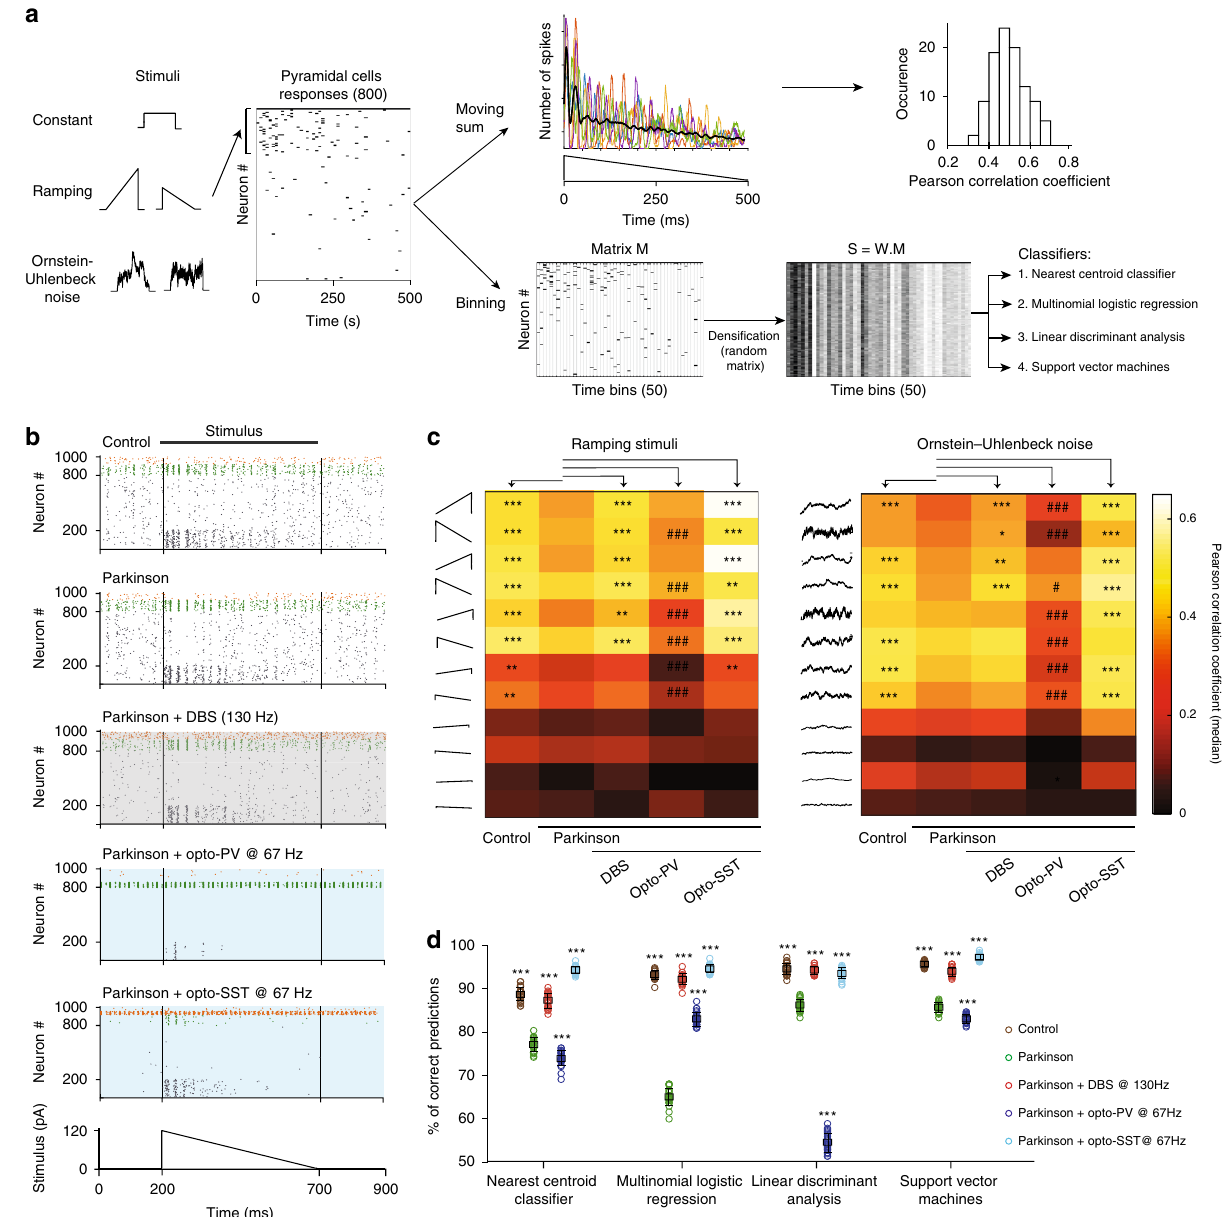
Fig. 7 Theoretical impact of DBS and opto-PV/SST on cortical information processing. a Procedure for calculating Pearson correlations between network responses and time-varying stimuli (4 constant stimuli, 8 ramping stimuli, and 8 stochastic stimuli) and for training the classi fi ers. Example traces of moving spike counts and the resulting distribution of correlation coef fi cients are displayed on the top right. Binned pyramidal cell spiking responses were fi rst densi fi ed using a random matrix to serve as inputs for the classi fi ers (cf. “ Methods ” ). b Raster plots of network responses to a ramp. c Heatmaps of median Pearson correlation coef fi cients ( n = 100 independent simulations) for ramping stimuli (left) and stochastic inputs (right). d Accuracy (mean ± SD, n = 25 independent simulations) of four different classi fi ers, de fi ned as the percentage of correct predictions of stimulus identity from pyramidal cell activity. Statistical comparisons to the parkinsonian condition are performed using One-Way ANOVA (or Kruskal – Wallis test for c ) with Tukey – Kramer post-hoc tests, * p < 0.05; ** p < 0.01; *** p < 0.001. Statistical tests are all two-tailed. For panels c , d : see Supplementary data (from bregma: AP 1.2mm, ML 1.2mm, DV 4.9mm). Mice who failed to display (27.5 mg/kg, i.m.; Imalgène, Mérial, Lyon, France). Mice were anesthetized with an spontaneous ipsilateral rotations (i.e., were seen to explore indifferently towards i.p. mix of ketamine (67 mg/kg) and xylazine (13 mg/kg, Rompun, Bayer, Puteaux, ipsi- and contralateral sides when observed in their homecage and on the scale France). All animals received a bolus of desipramine (Tocris, Bio-Techne, Lille, during daily weighting, without amphetamine challenge) and weight loss in post- France) dissolved in saline (rats: 25mg/kg, i.p.; mice: 20 mg/kg, i.p.) 30min before lesion recovery were excluded from the study. the injection of 6-OHDA (Sigma, Steinheim, Germany) to prevent neurotoxin- induced damage of noradrenergic neurons. For rats, 7μL of vehicle (saline con- taining 0.01% w/v ascorbic acid, Sigma) or 6-OHDA (2.5 mg/ml in vehicle) was In vivo intracellular electrophysiological recordings . After 3 weeks of recovery, injected at 16μL/h in the substantia nigra pars compacta (from the interaural line: AP 3.7mm, ML 2.1 mm, 7.55mm depth from the cortical surface). For mice, we performed intracellular recordings in 6-OHDA-lesioned and sham rats main- 0.5μL of vehicle (saline containing 0.02% w/v ascorbic acid) or 0.5μL of 6-OHDA tained in narcotized and sedated states with fentanyl (4 μg/kg, i.p.; Janssen-Cilag, (6mg/ml in vehicle) was injected at 3 μL/h in the right medial forebrain bundle Issy-Les-Moulineaux, France), immobilized with gallamine triethiodide (40mg,